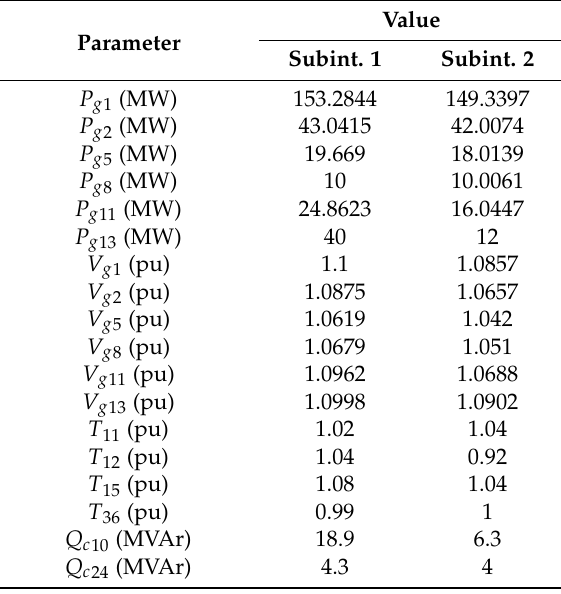
Table A5. Optimal solutions for subinterval 1 of the IEEE 118 buses system obtained by ENCSA.